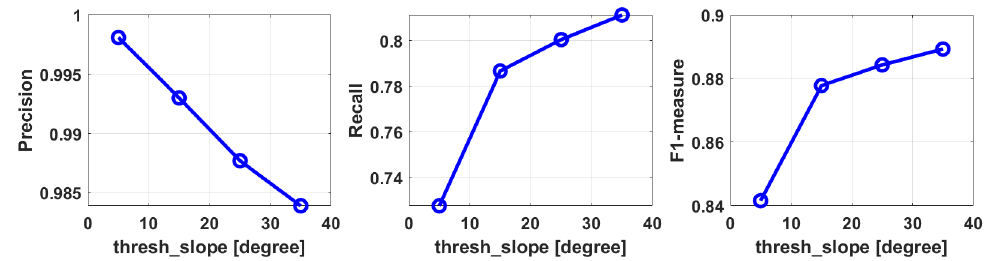
Figure 14. Terrain modeling accuracy on the SemanticKITTI sequence 07 dataset by setting thresh _ slope to different